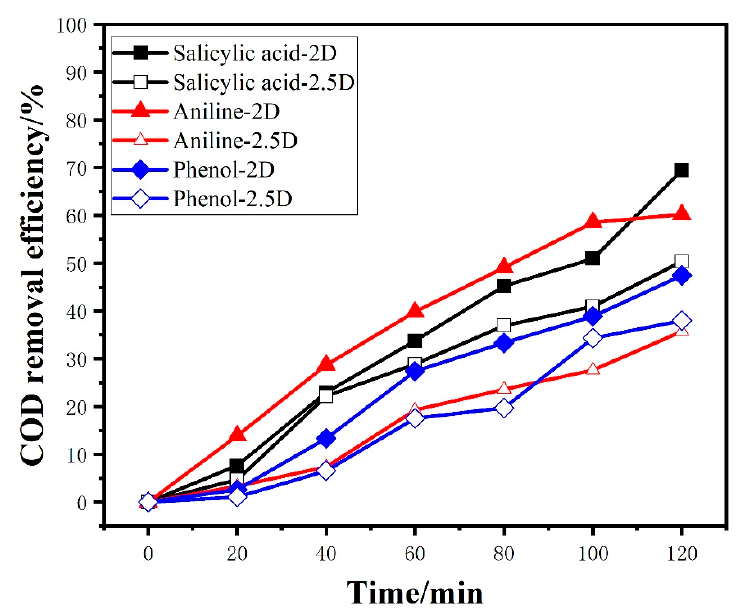
Figure 5. The Chemical Oxygen Demand (COD) removal efficiency of three organic target by 2.5D and 2D electrode (electrolysis condition: concentration 100 ppm, 50 mA/cm 2 , 0.1 mol/L Na 2 SO 4 , room temperature).